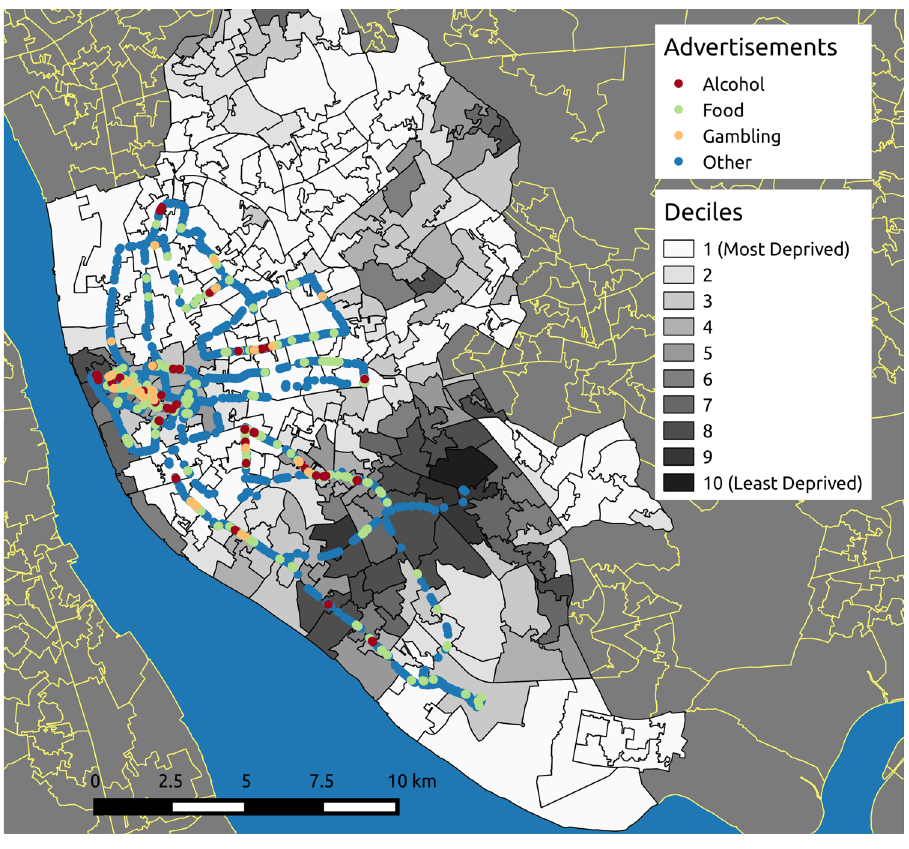
Figure 3. Liverpool advertisement locations by Lower Super Output Areas (LSOAs). A color gradient indicates the level of deprivation, with white and black being the most and least deprived respectively. This map was created using QGIS 2.8.6-Wien 39 .